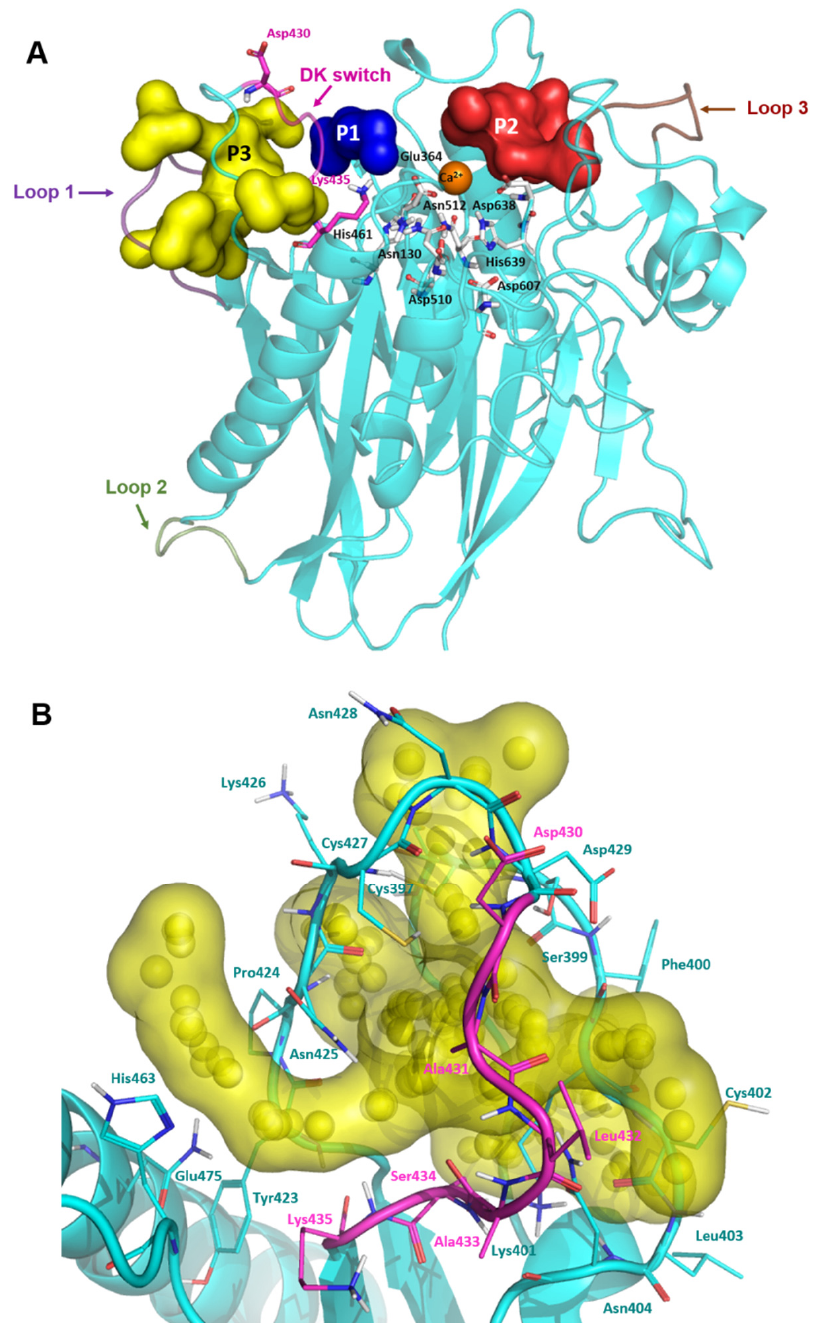
Figure 3. Complete model of human nSMase2 and pocket visualization. ( A ) Modelled loop 1 is shown in violet, loop 2 in green, and loop 3 in brown. DK switch is shown in magenta with residues Asp430 and Lys435 highlighted. Selected pockets are shown in surface and labelled as follows: pocket 1 (P1) in blue, pocket 2 (P2) in red, and pocket 3 (P3) in yellow. Active site residues are shown in grey sticks and labelled and Ca 2+ is shown as an orange sphere. ( B ) Detailed view of Pocket 3 shown as yellow surface. Spheres represent the alpha spheres calculated by Fpocket. Residues that comprise the pocket are shown in cyan lines and labelled. Residues forming the DK switch are shown in magenta lines and labelled. P3 (yellow surface in Figure 3A) had the highest volume and druggability score out of the three cavities. Moreover, it included the loop containing the DK switch motif, Asp430, Ala431, Leu432, Ala433, Ser434, and Lys435 (Figure 3B). Other residues worth of